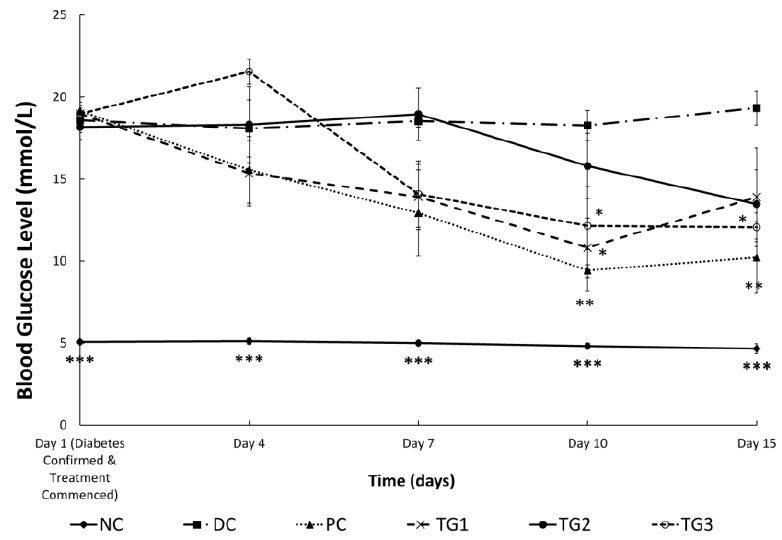
Figure 3. Sub-chronic (14 days) treatment with Gongronema latifolium extract in STZ-induced diabetic rats ( n = 6). Values are expressed as the mean ± SEM, * = p < 0.05; ** = p < 0.01; *** = p < 0.001 vs. DC.